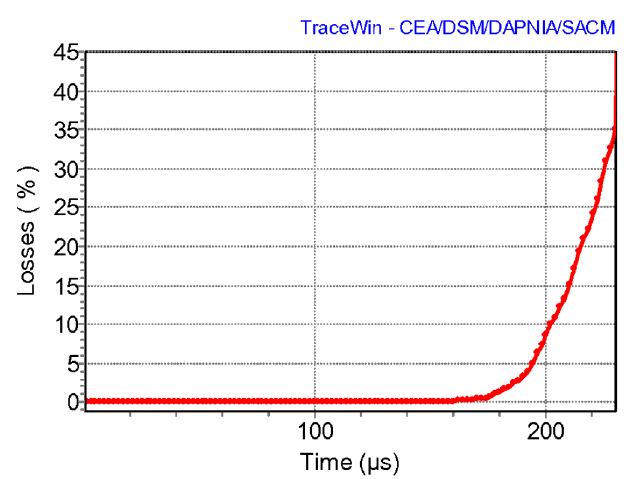
FIG. 10. (Color) Beam losses according to time.